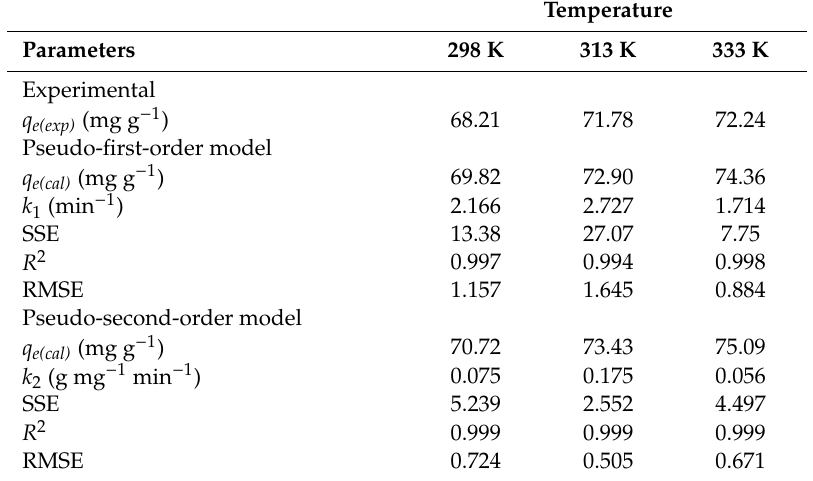
Table 1. Parameters of the pseudo-first-order and pseudo-second-order kinetic model, considering di ff erent temperatures.